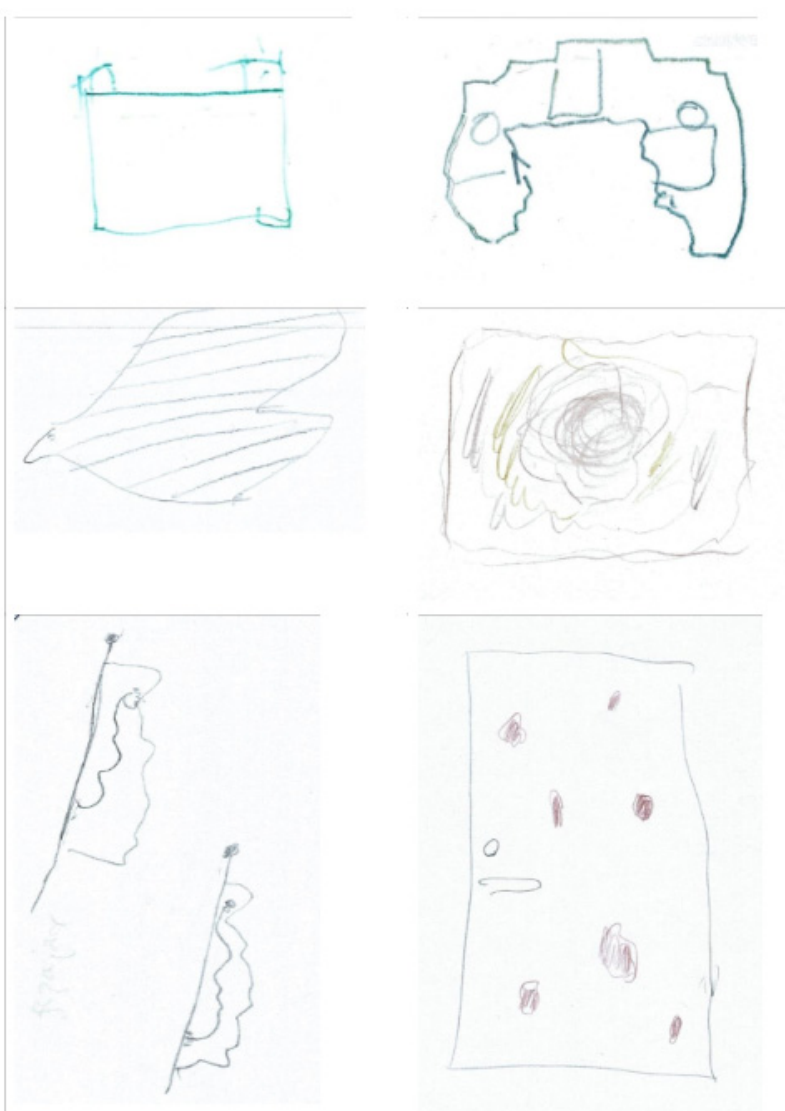
Figure 1. Selected illustrations of the visual hallucinations drawn by the patients.